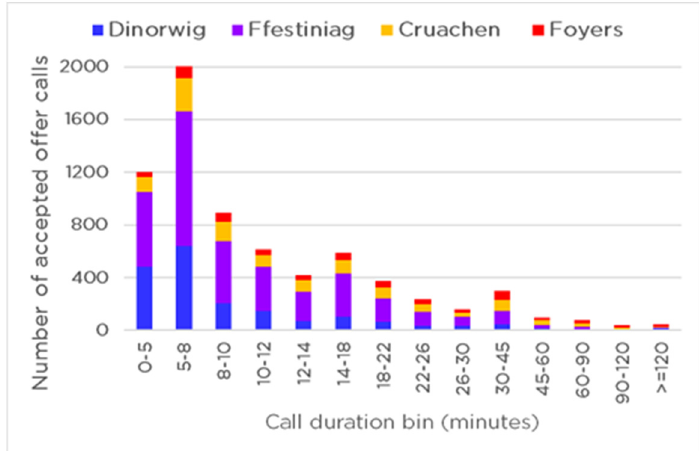
Figure 2. Distribution of accepted offers of four main PS plants [27].